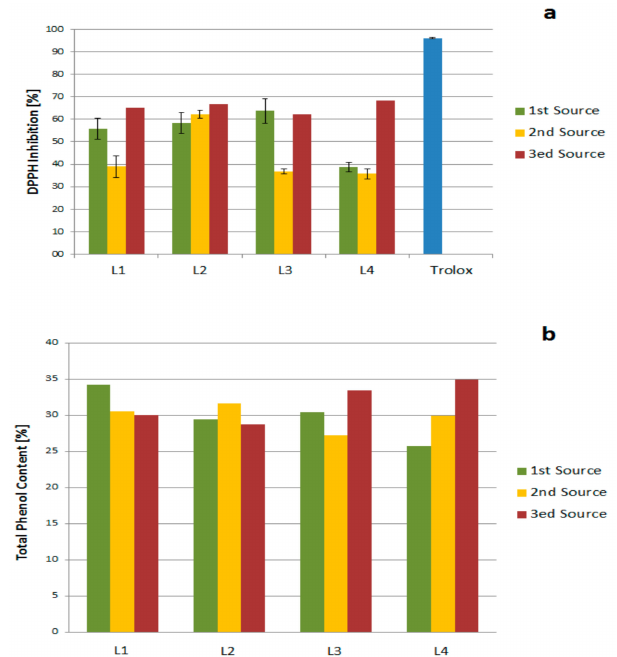
Figure 12. Source effect on ( a ) DPPH inhibition and ( b ) Total Phenol Content (TPC). The effect of storage on the antioxidant activity and the TPC of the purification fractions was also investigated. The fractions were studied after purification, then stored for six months. DPPH inhibition and TPC were performed again for the stored fractions. The results (Figure 13) showed that the effect of storage on the DPPH inhibitions of the fractions decreased for all fractions. In contrast, the TPC of the fractions increased, likely due to hydroxyl formation during storage. The antioxidant activity was not affected. In ongoing studies, the structure of those degradation products will be analyzed.